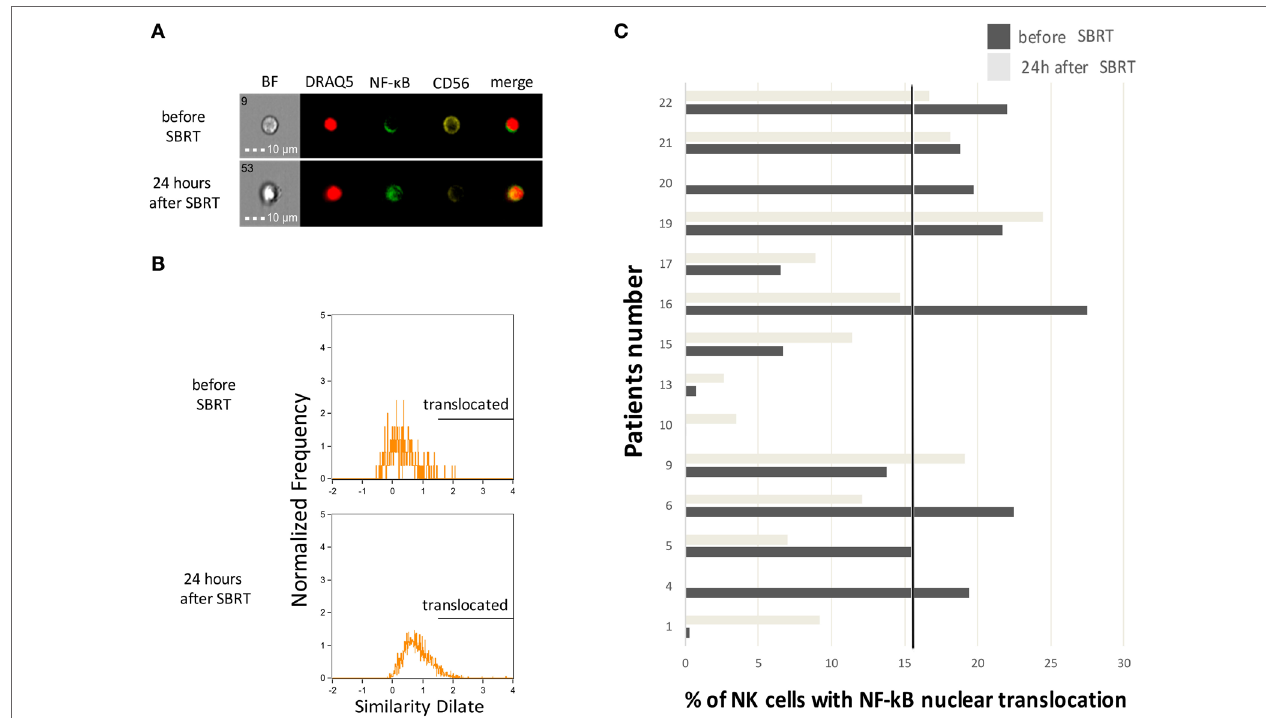
FigUre 2 | Natural killer (NK) cell activation status before and after SBRT. (a) Representative cell pictures obtained by multispectral flow cytometry on cell samples from patient no. 10 before and 24 h after the first SBRT fraction. BF, brightfield. (B) Representative multispectral flow cytometry plots showing typical histograms of NK cells without (upper plot) or with (lower plot) the nuclear translocation of NF- κ B. Analysis performed on cell samples obtained from patient no. 10 before and 24 h after the first SBRT fraction. (c) Percentage of NK cells showing nuclear translocation of the p65 subunit of the NF- κ B complex measured through multispectral flow cytometry, in patients before and 24 h after SBRT. In patients no. 4 and 20, the analysis was performed only before SBRT due to sample availability. The solid dot line represents the baseline median